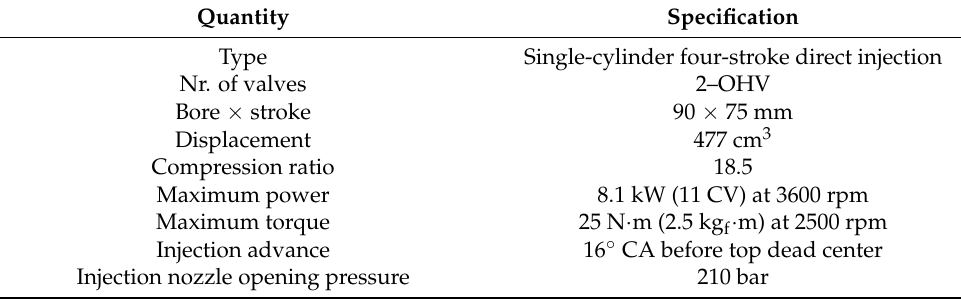
Table 1. Technical characteristics of the tested diesel engine (Ruggerini